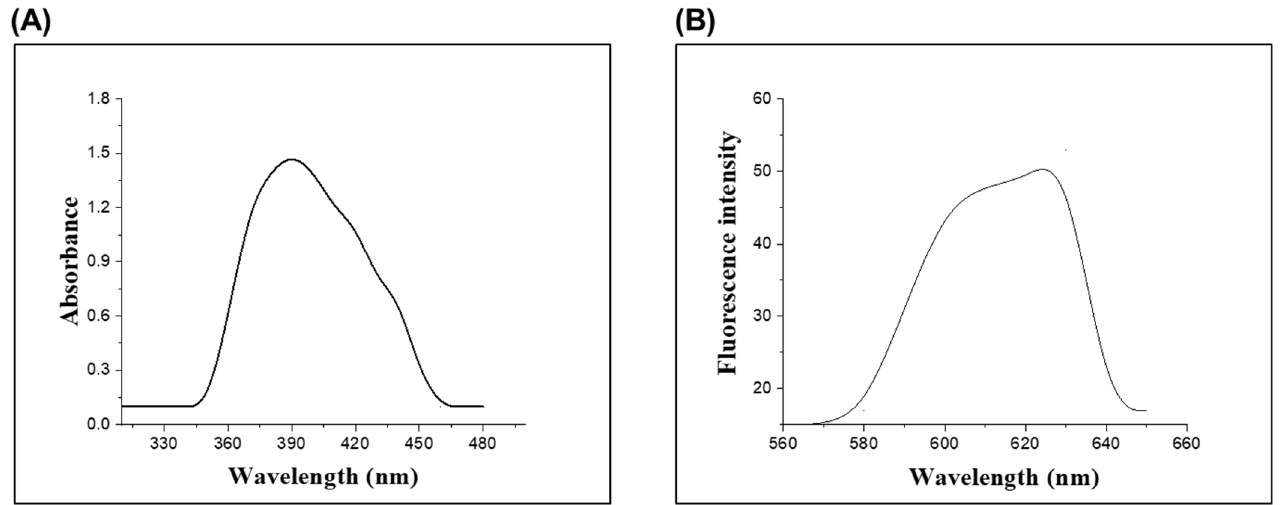
Figure 1. ( A ) UV-Visible absorption spectrum of chemosensor CM1 . ( B ) Fluorescence emission spec- trum of the chemosensor CM1 when excited at 390 nm.